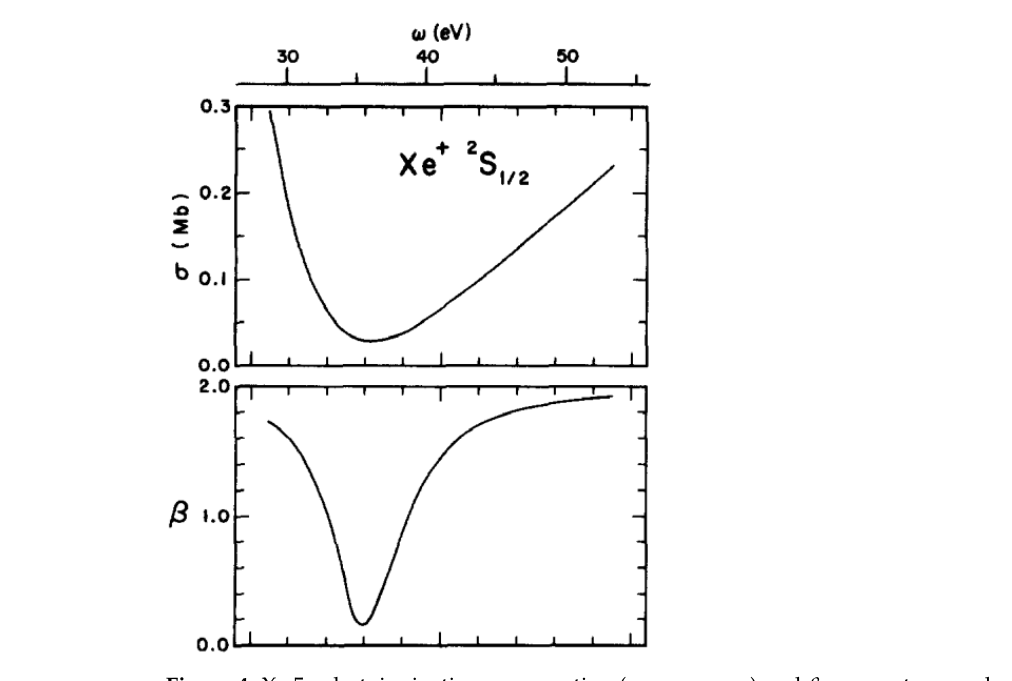
NEAR-THRESHOLD PHOTOIONIZATION OF THE Xe 3 d . . .